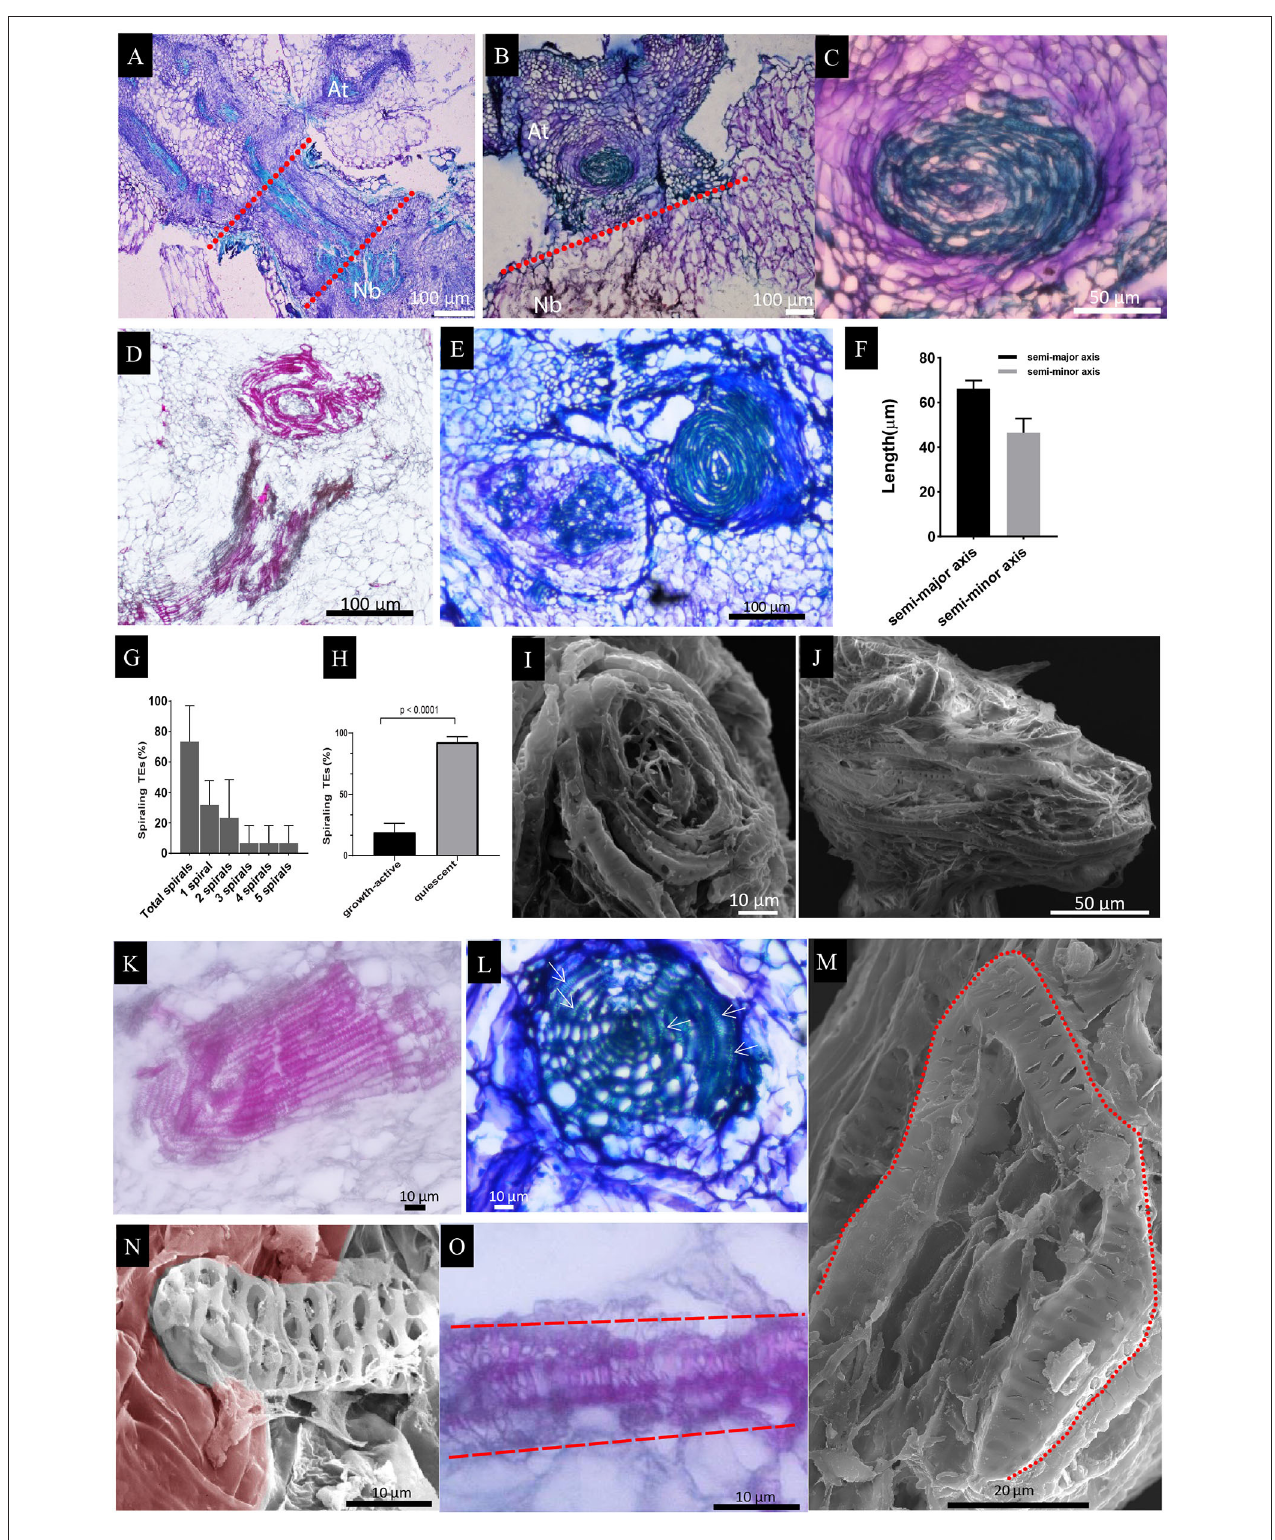
FIGURE 5 | Histological staining of longitudinal sections in the At / Nb grafts and SEM observation of spiraling TEs. (A) A section showing the growth-active grafts (groups A and B). The dashed red line indicated the graft union. (B) A section showing the quiescent graft. (C) The enlarged spiraling structure in section B. (D) the spiraling structure of At and the xylem bundles of Nb (group C). (E) two spiraling structures were found above the graft union of quiescent graft (group C). (F) The